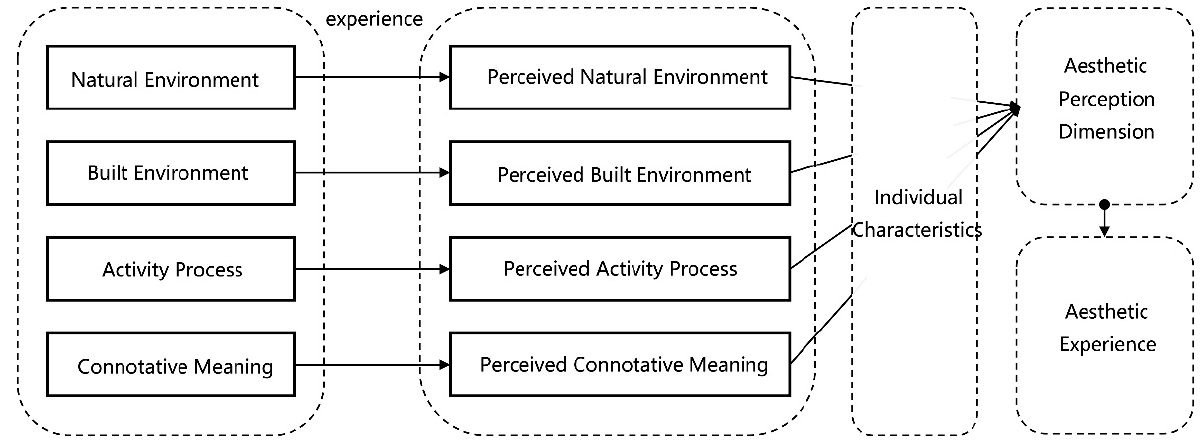
Figure 2. Formation Mechanism of Aesthetic Perception Dimension.